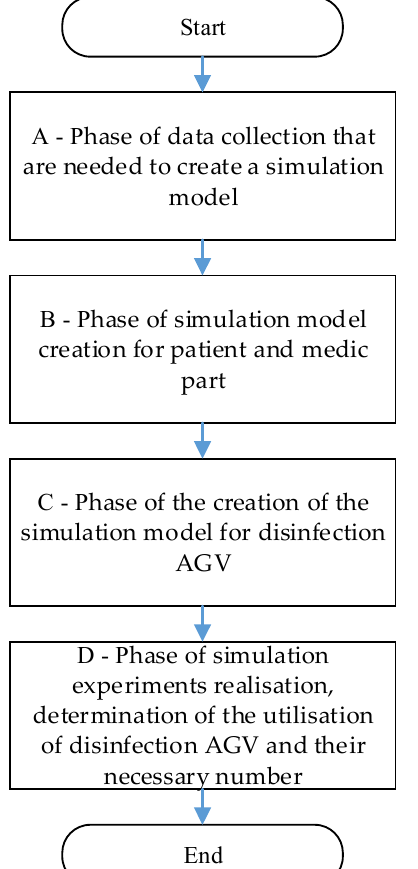
Figure 1. Blocks of a system for the analysis of disinfection automated guided vehicle utilisation.